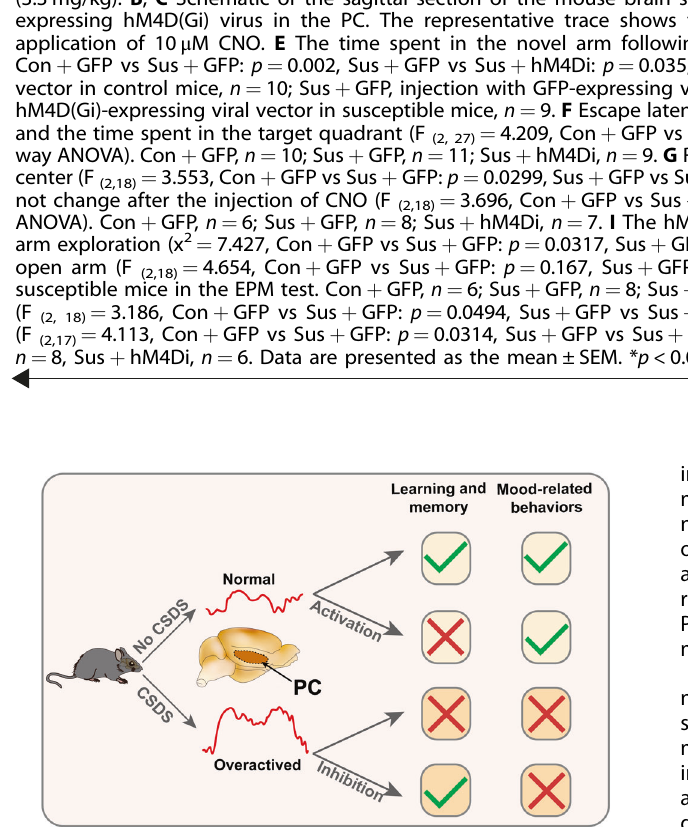
Fig. 5 Learning and memory dysfunction but not mood-related disorders were alleviated by the chemogenetic inhibition of the piriform cortex (PC) excitability neurons. A Experimental timeline of virus injection for investigating the behavioral impact, CNO injections (3.3 mg/kg). B , C Schematic of the sagittal section of the mouse brain shows hM4D(Gi)-GFP virus injection. D Current-clamp recording of expressing hM4D(Gi) virus in the PC. The representative trace shows that PC neurons expressing hM4D(Gi) can be inhibited by bath application of 10 μ M CNO. E The time spent in the novel arm following PC injections of AAV-GFP and AAV-hM4D(Gi) (F (2, 27) = 5.996, Con + GFP vs Sus + GFP: p = 0.002, Sus + GFP vs Sus + hM4Di: p = 0.035; One-way ANOVA). Con + GFP, injection with GFP-expressing viral vector in control mice, n = 10; Sus + GFP, injection with GFP-expressing viral vector in susceptible mice, n = 11; Sus + hM4Di, injection with hM4D(Gi)-expressing viral vector in susceptible mice, n = 9. F Escape latency ( F (2, 27) = 1.878, p = 0.172; Two-way repeated measures ANOVA) and the time spent in the target quadrant (F (2, 27) = 4.209, Con + GFP vs Sus + GFP: p = 0.0402, Sus + GFP vs Sus + hM4Di: p = 0.0334; One- way ANOVA). Con + GFP, n = 10; Sus + GFP, n = 11; Sus + hM4Di, n = 9. G Representative animal trace of the open fi eld test. H The time in the